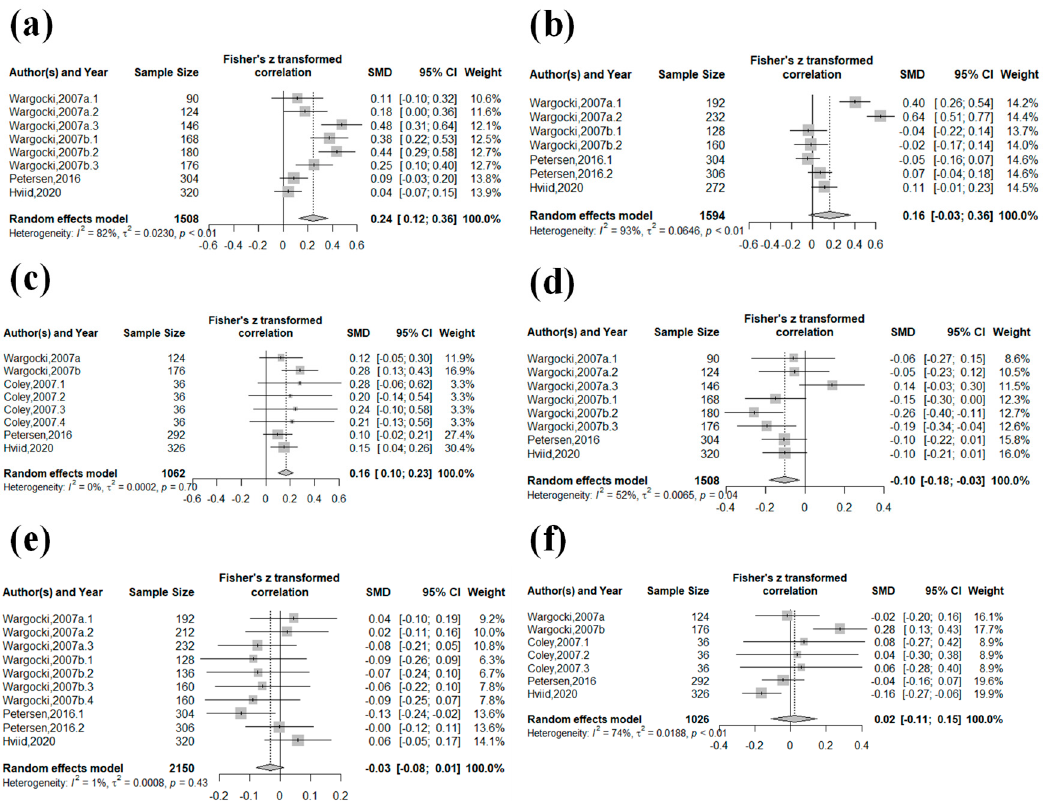
Figure 3. Association between the increase in ventilation rate and the performance of school tests according to subgroups: ( a ) arithmetic, the task performance speed; ( b ) arithmetic, the error rate; ( c ) verbal comprehension, the task performance speed; ( d ) verbal comprehension, the error rate; ( e ) cognitive skill, the task performance speed; and ( f ) cognitive skill, the error rate.